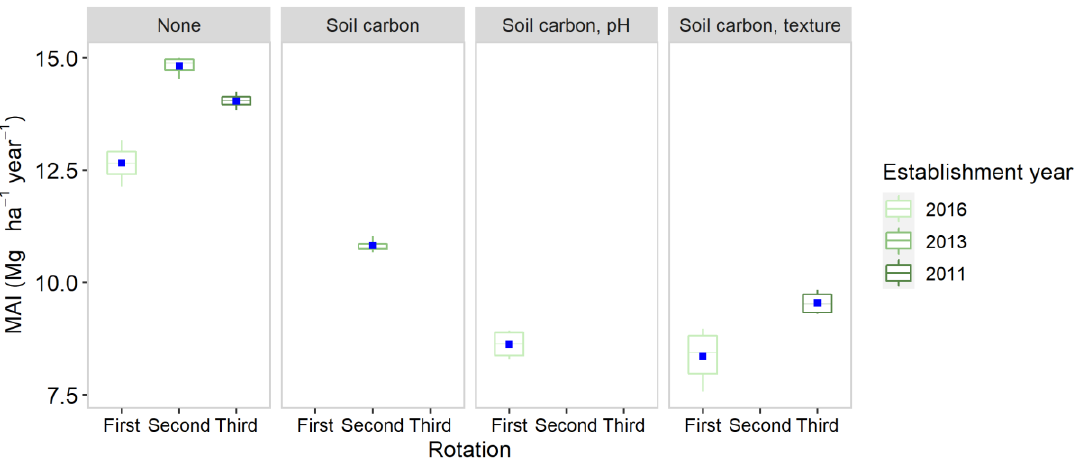
Figure 4. MAI (mean annual increment) of willow above-ground biomass dry matter in Ukraine after first, second and third rotation, under different marginality factors—no marginality (none), low soil organic matter content (soil carbon), low soil pH (pH), unfavorable soil texture (texture) (boxes represent interquartile range; median is shown as center horizontal line in the box; whiskers show minimum and maximum observed values; mean values are represented by the blue